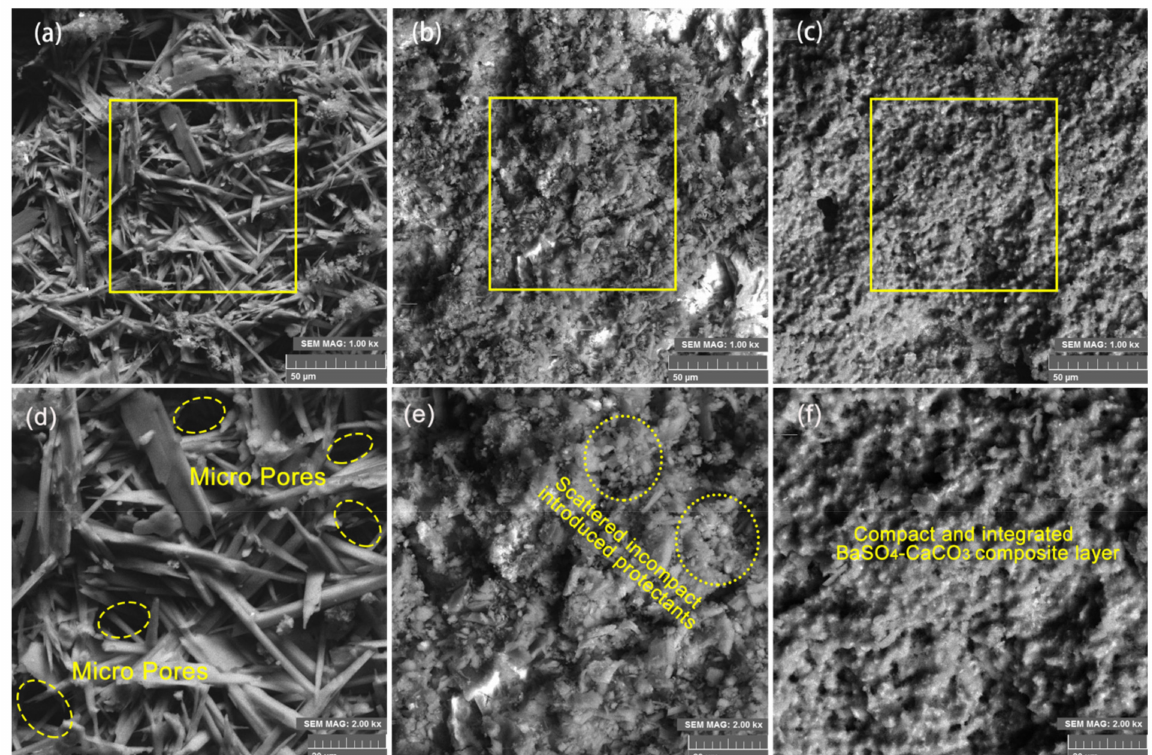
Figure 2. Surface morphology of the specimens with different magnifications (the yellow rectangle areas of the ( a – c ) are magnified to ( d – f ), respectively), ( a , d ): blank specimen, ( b , e ): treated specimen before water supply, ( c , f ): treated specimen after water supply.